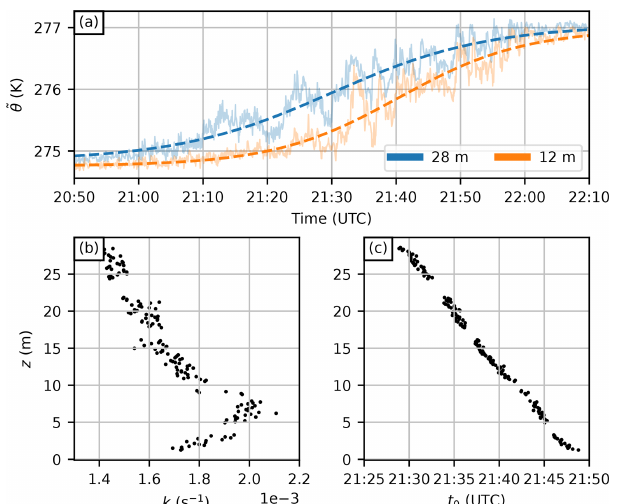
Figure 9. (a) Time series of ˜ θ from two heights (solid lines) and the corresponding logistic regression curve (dashed lines) for the event on 27 January 2020. (b) The rate parameter ( k ) of a logistic regression on ˜ θ as a function of height. (c) Same as (b) but for the temporal midpoint parameter ( t 0 ) of the function.